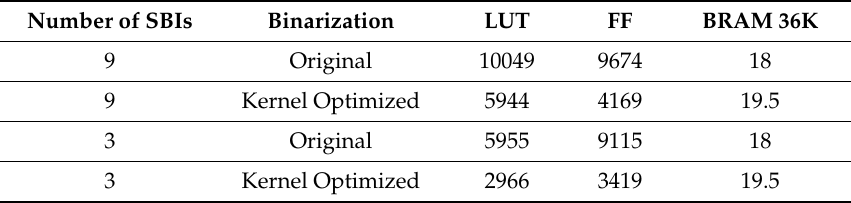
Table 4. Implementation type vs. hardware usage.